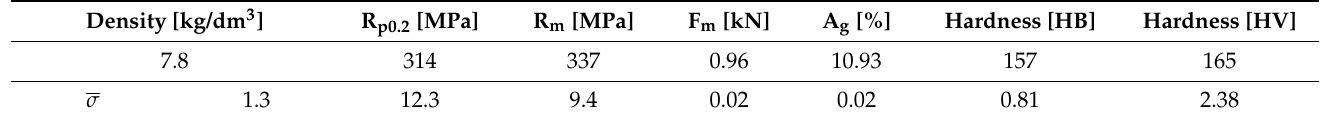
Table 2. Mechanical properties of coated ET 110-30LS steel (at T = 20 ◦ C).